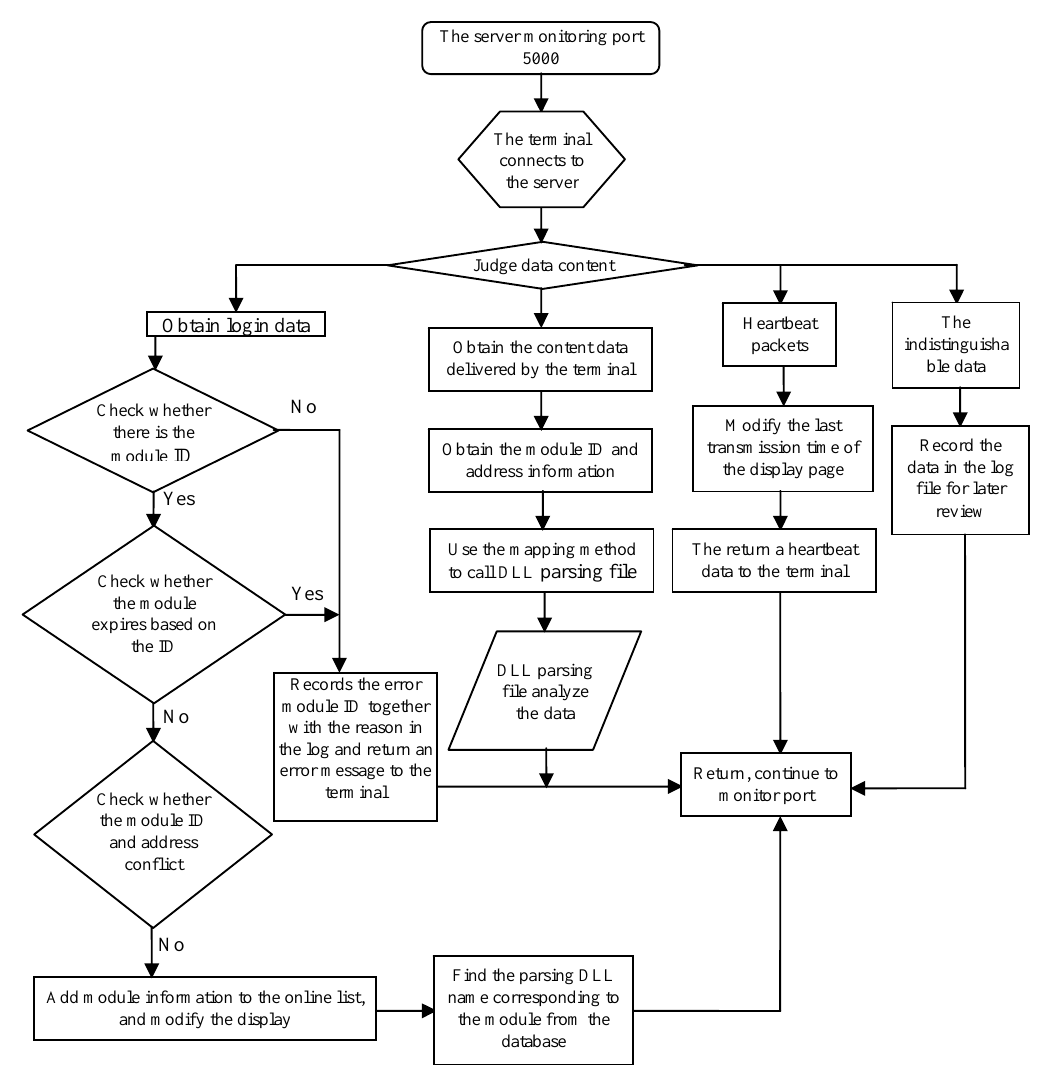
Figure 6. The working flow of the data